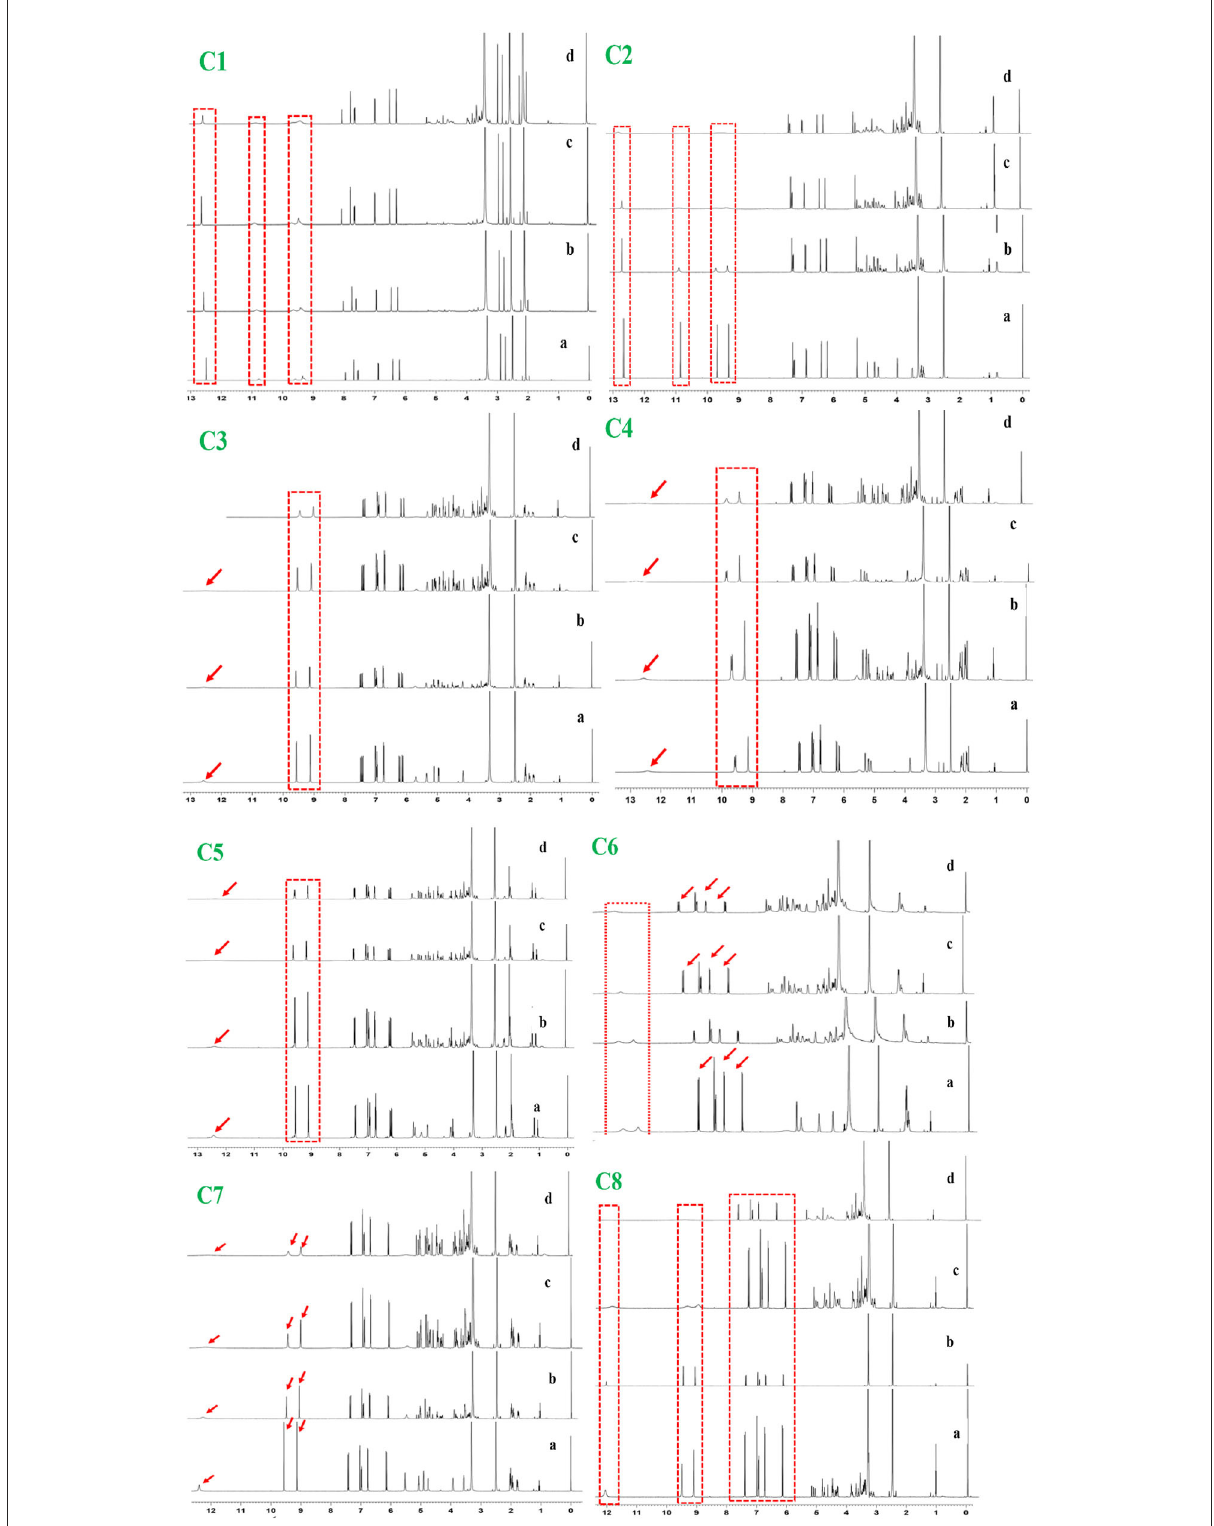
FIGURE1 1 H NMR analysis of phenolic compounds with XOD. C1, quercetin; C2, quercetin-3-rhamnoside; C3, 4,5-O-dicaffeoylquinic acid; C4, 3,5-O-dicaffeoylquinic acid; C5, 3,4-O-di-caffeoylquinic acid; C6, 4-O-caffeoylquinic acid; C7, 3-O-caffeoylquinic acid; C8, caffeic acid. The letter a – d from each figure means the various concentrations of XO (0.1 – 0.5 mg/ µ l). 1 H NMR: Proton nuclear magnetic